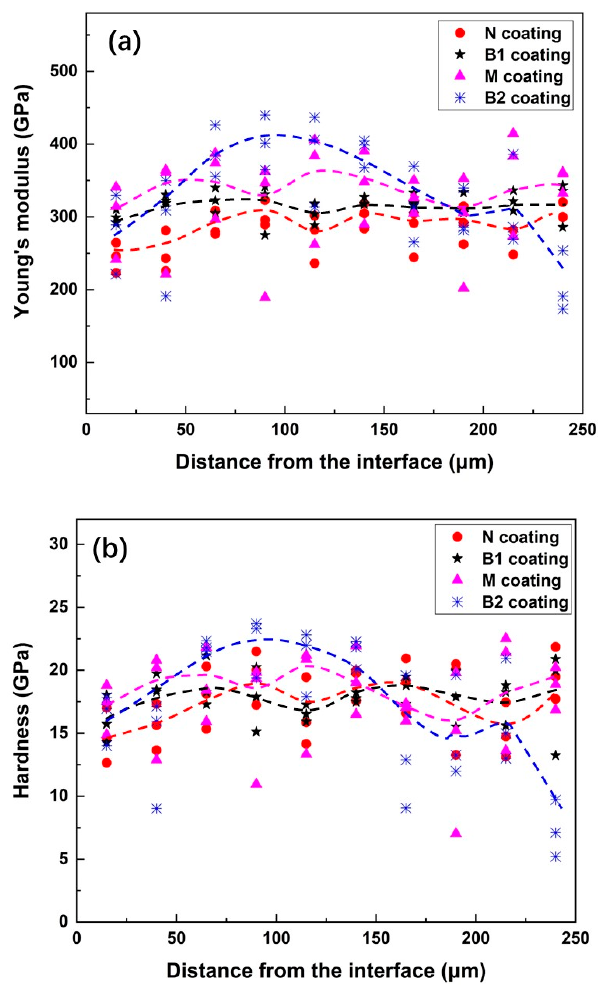
Figure 9. The through-thickness distributions of the Young’s modulus ( E ) and hardness ( H ) in the coatings. ( a ) The Young’s modulus; ( b ) the hardness.